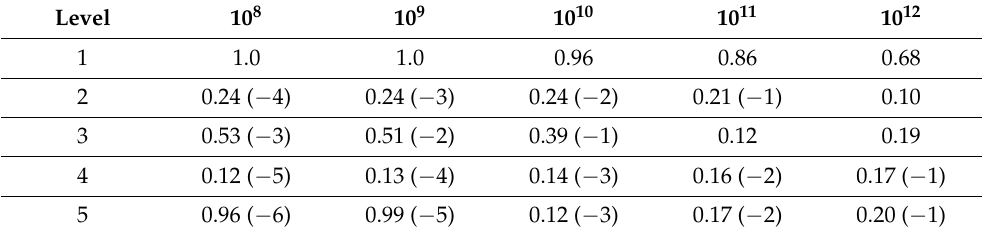
Table 3. N i /N for various electron densities N e (cm − 3 ) for Ca XIV.